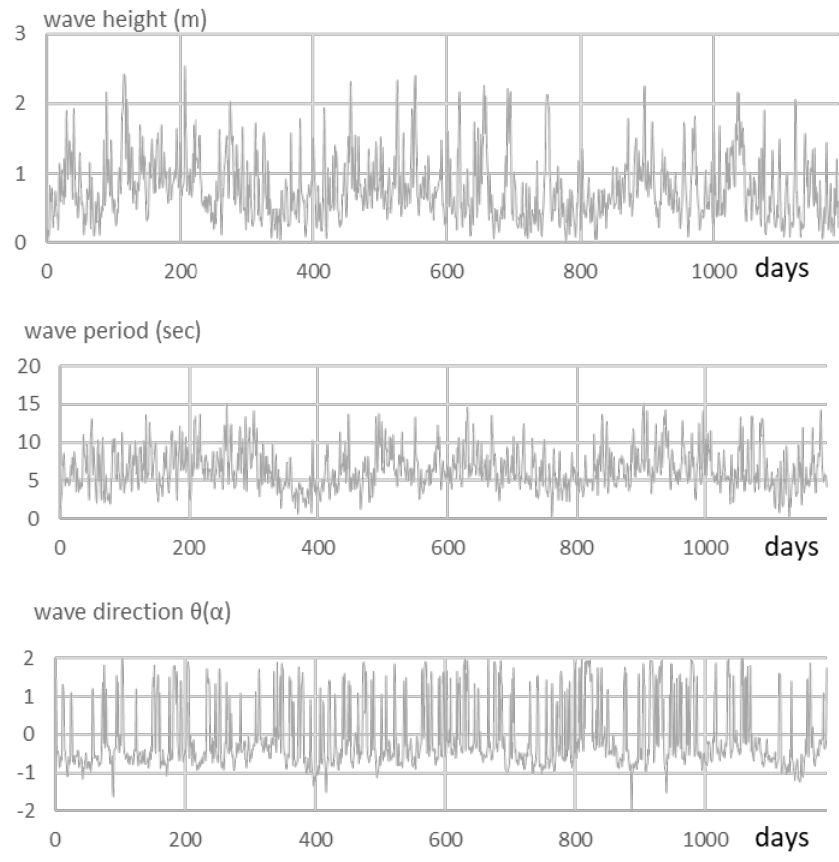
Figure 10. Time series of the simulated daily wave-data in the time period from: 1 April 2013 to 30 June 2016.